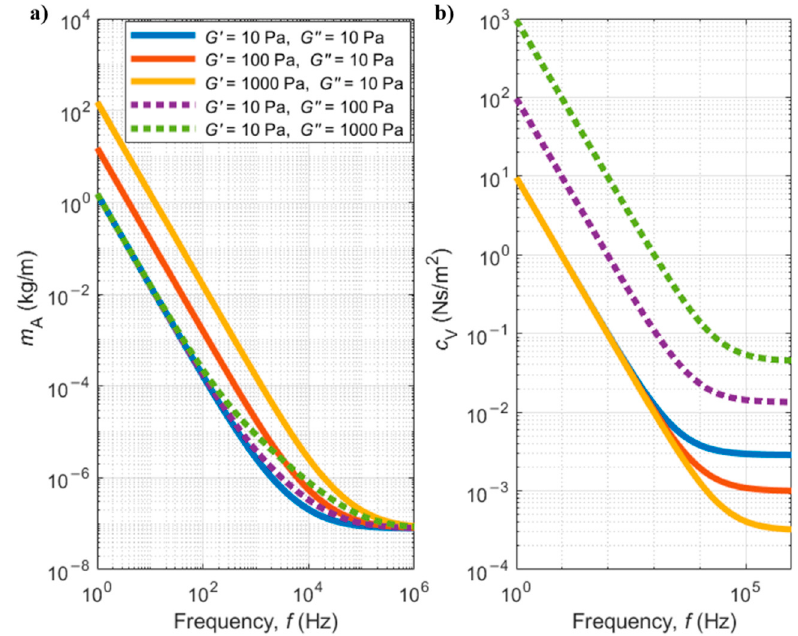
Figure 9. ( a ) Added mass and ( b ) viscous damping per unit length of a rectangular microcantilever (width w = 10 µ m) as a function of the frequency of oscillation in the fluid (water, ρ f = 1000 kg/m 3 ) and of the elastic and viscous parts of the dynamic modulus, calculated with Equations (70) and (71). Experimentally, m A and c V are obtained from the measured amplitude, H ( ω ) , and phase, φ ( ω ) , spectra using Equations (64a) and (64b), as described previously. Note that of the dynamic modulus assuming a constant fluid